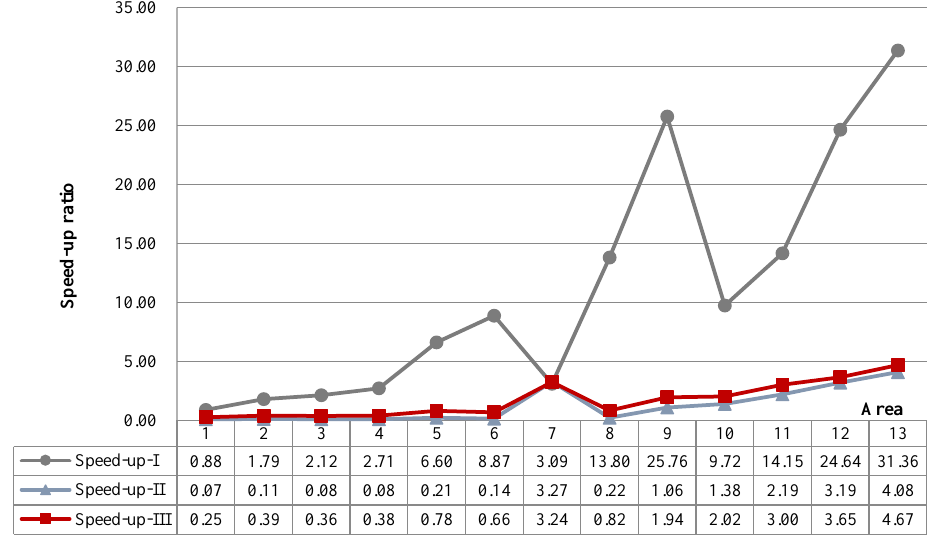
Figure 10. The speed-up ratio of PSOM-GPU compared with PRM. I, II and III denote the three aspects of similarity computation, matching-relationship identification and global process, respectively.